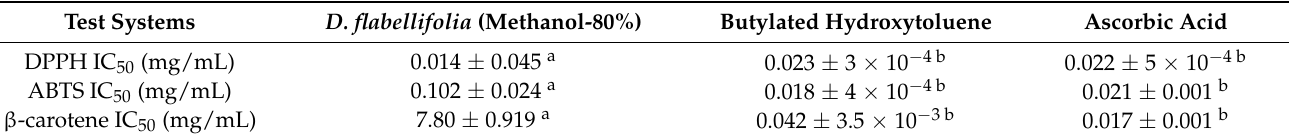
Table 2. Antioxidant activities of D. flabellifolia methanol/water extract compared to known drugs.